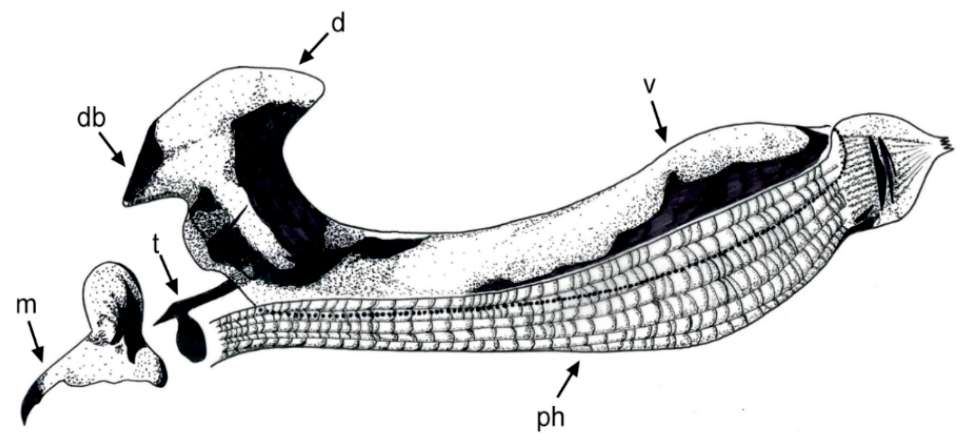
Figure 4. Meromacrus cactorum sp. nov., head skeleton, lateral view. Sclerotised areas or parts of the head skeleton are indicated in different black intensities. The pharyngeal ridges in this species are heavily sclerotised structures represented here in lighter colour than in the actual specimen. Legend: d, dorsal cornu; db, dorsal bridge; m, mandibular hook; ph, pharyngeal ridges; t, tentorial arm; v, ventral cornu. Scale bar = 250 µm.